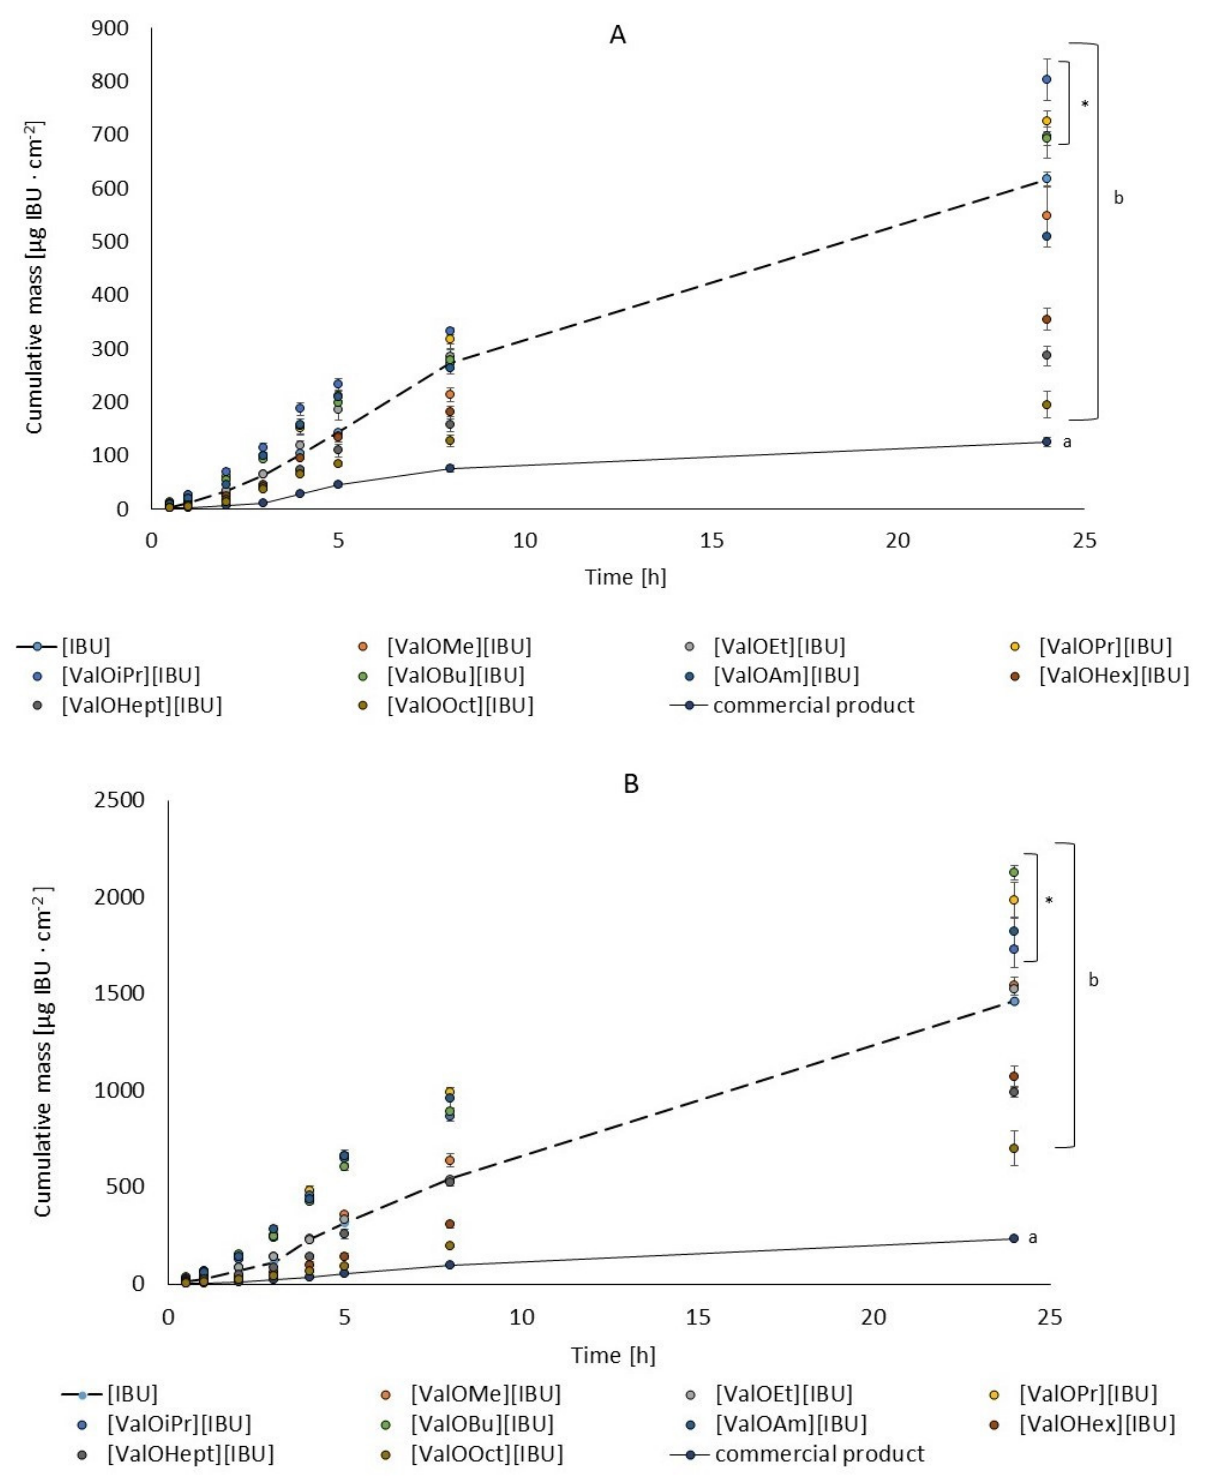
Figure 2. The cumulative amount of ibuprofen and its derivatives permeated human skin ( A ) and transdermal diffusion test model ( B ) as a function of time. Each point represents the mean ± SD ( n = 3). For * p < 0.001 versus the control (pure ibuprofen), different letters also mean the essential between Pentravan ® and commercial product, where a — commercial product, b — Pentravan ® .